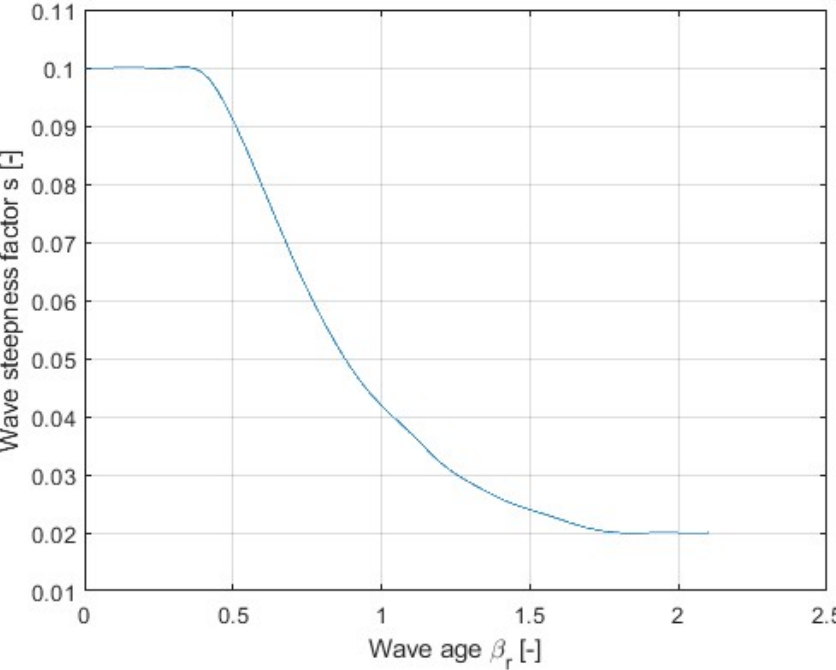
Figure 3. Wave age at natural roll period based on standard wave steepness table.